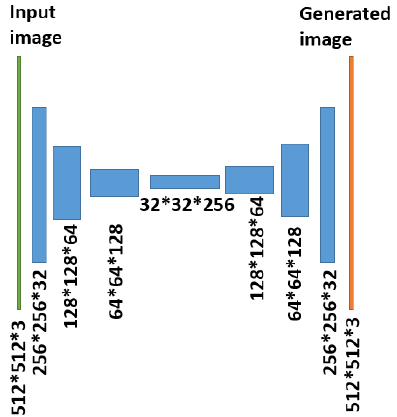
Figure 4. The encoder–decoder architecture of the generator.